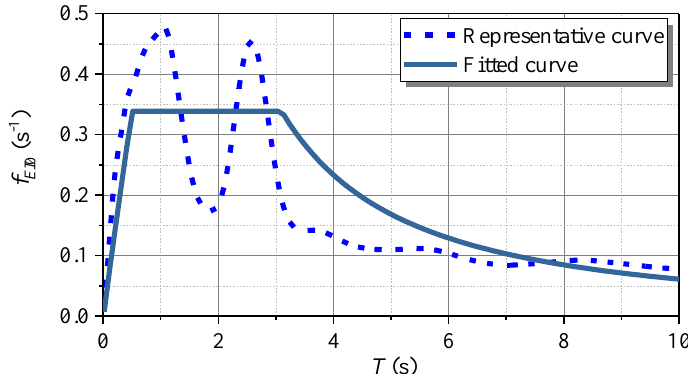
Figure 16. Representative and fitted curves for seismic-induced input energy spectrum of SDOF element connected to a single dashpot. Table 5. Parameters for fitted elastic seismic-induced input energy spectrum.